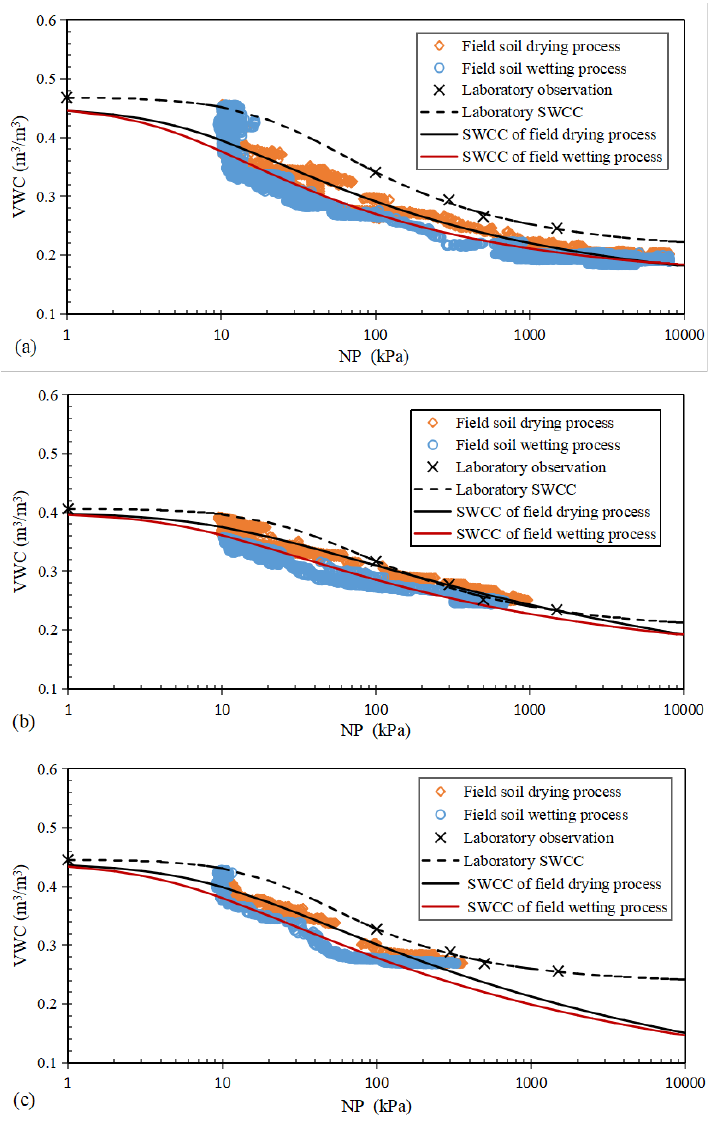
Figure 8. SWCC was fitted using field monitoring data and laboratory measurement points at ( a ) 10 cm depth, ( b ) 20 cm depth and ( c ) 40 cm depth.